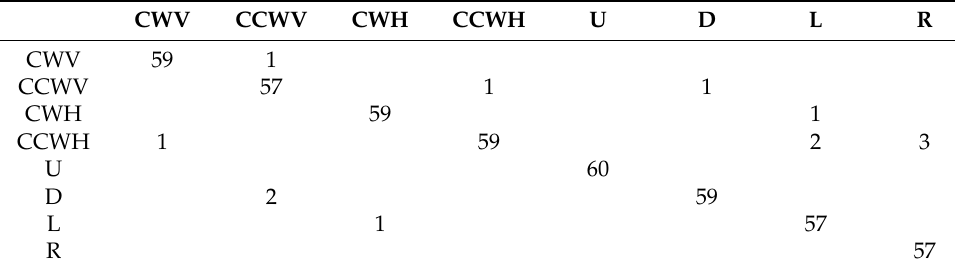
Table 5. Confusion matrix of GRU.